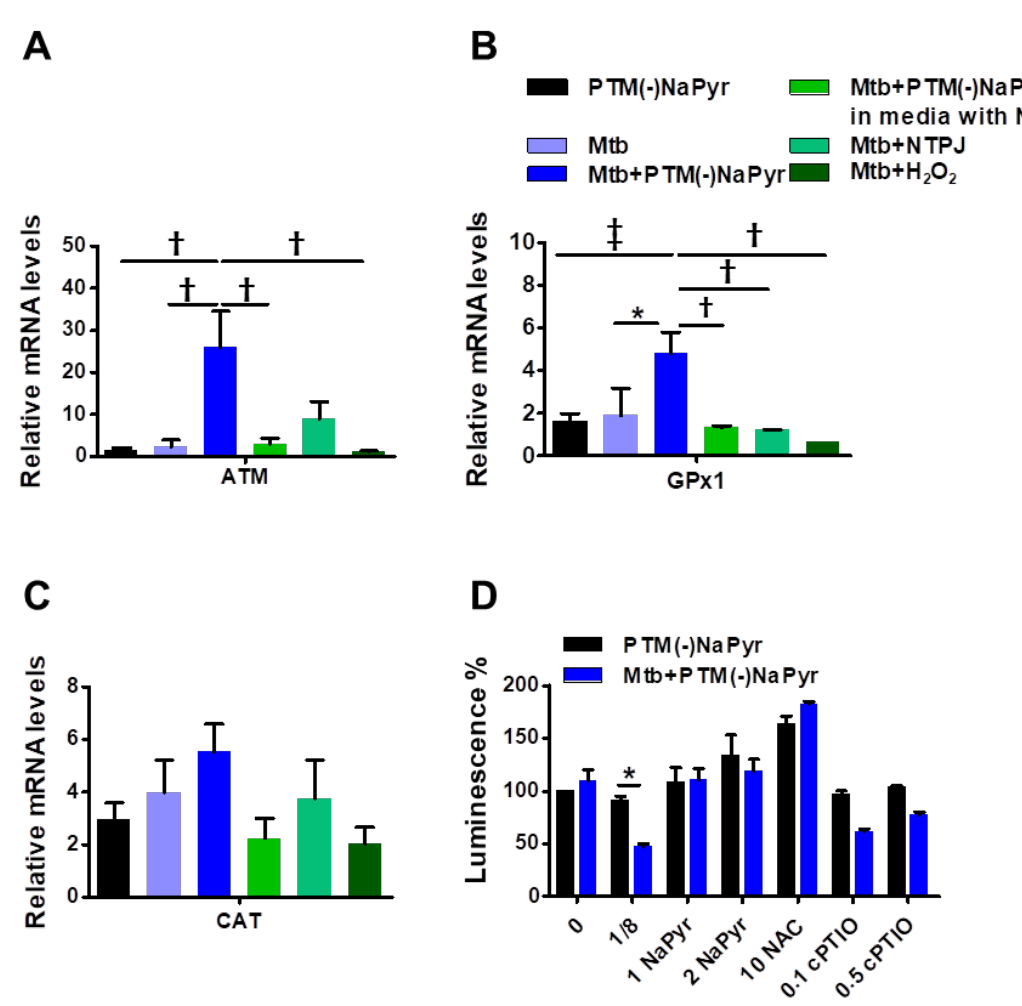
Figure 6. Plasma-treated medium stimulates antimycobacterial defenses in BMDMs. ( A – C ) Uninfected or Mtb -infected BMDMs (MOI 1) were incubated in undiluted and 8-fold-diluted PTM without NaPyr, then exposed for 60 s to NTPJ, and 250 µ M H 2 O 2 for 24 h in media without.NaPyr. Mtb -infected cells were incubated with NaPyr followed by 8-fold-diluted PTM without NaPyr) in medium containing NaPyr. The mRNA expression of ATM ( A ), GPx1 ( B ), and CAT ( C ) was quanti- fied using RT-PCR. Fold induction was calculated by comparison with 18 S rRNA untreated control. ( D ) Control, uninfected, and Mtb -infected BMDMs were incubated with 8-fold-diluted PTM without NaPyr, 8-fold-diluted PTM with 1 and 2 mM NaPyr, NAC (10 mM), and 0.1 and 0.5 mM cPTIO for 24 h. Cell viability was assayed using the CellTiter-Glo ® assay. Error bars show standard deviations of the means. * p < 0.05, † p < 0.01, and ‡ p < 0.001; n =